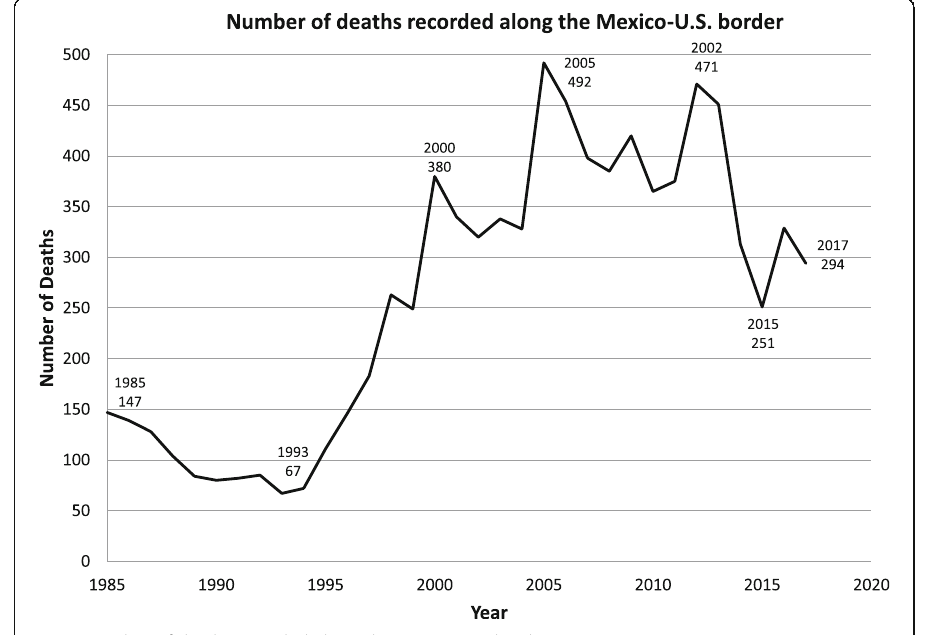
Fig. 8 Number of deaths recorded along the Mexico-U.S.